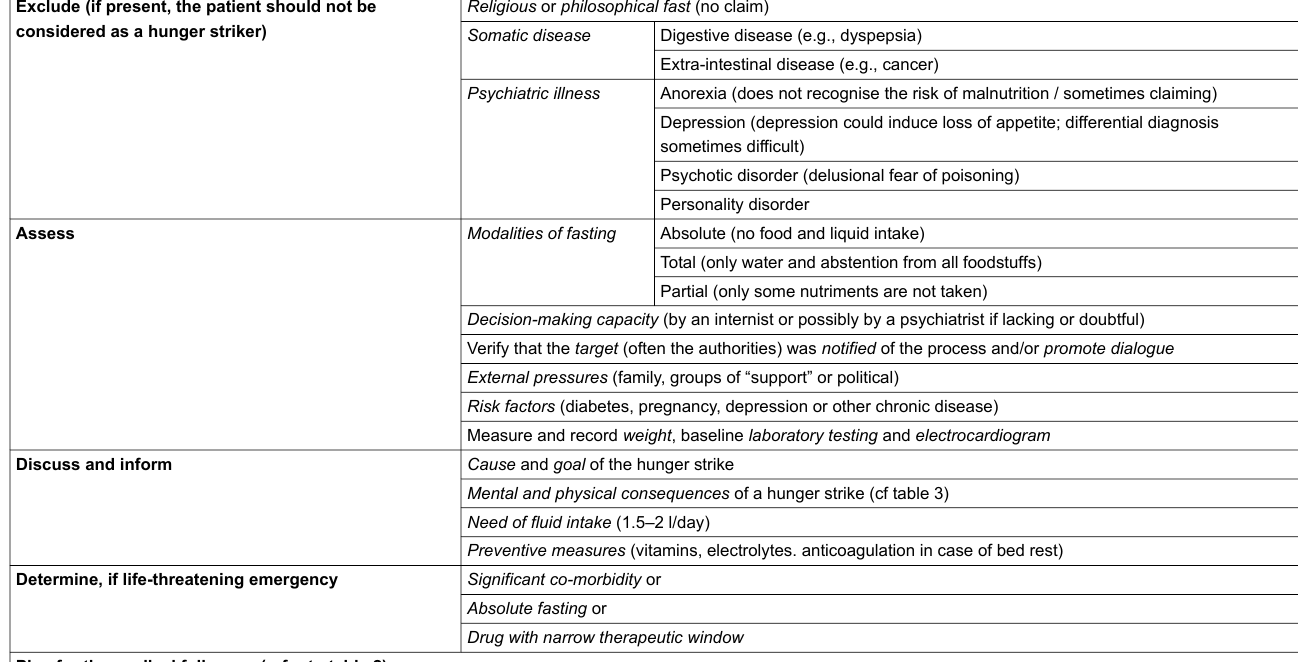
Table 1: Elements to be considered during the first medical consultations in a patient suspect of hunger strike (maximum 24 hours after hunger strike announcement). Religious or philosophical fast (no